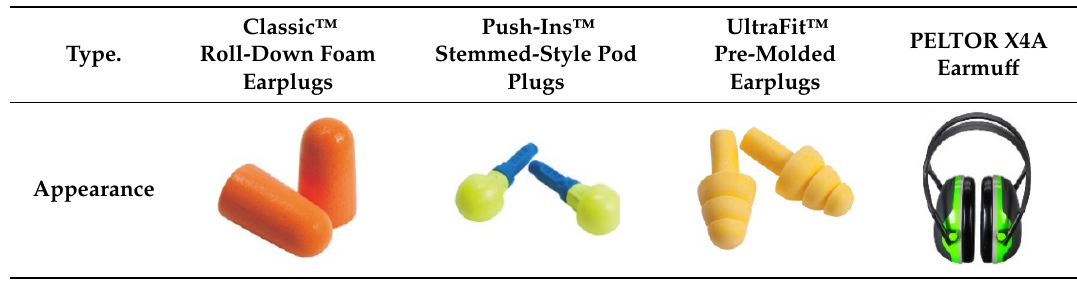
Table 3. Various types and appearances of the HPD samples tested in this study.